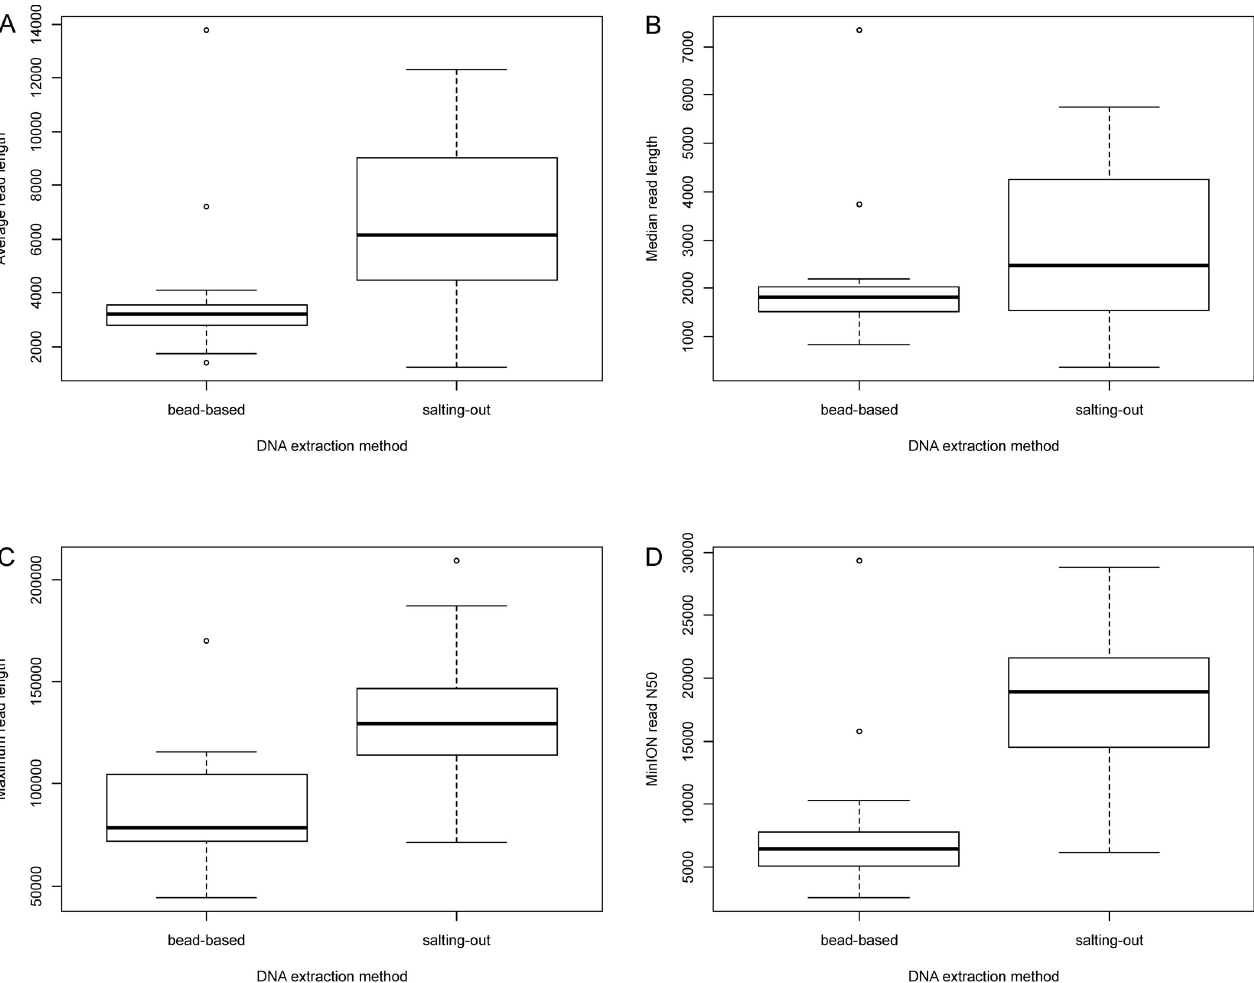
Fig 3. Read length-related metrics of the sequencing data according to the DNA extraction method. (A) Average read length (bp), (B) Median read length (bp), (C) Maximum read length (bp), (D) Read length N50 (bp).